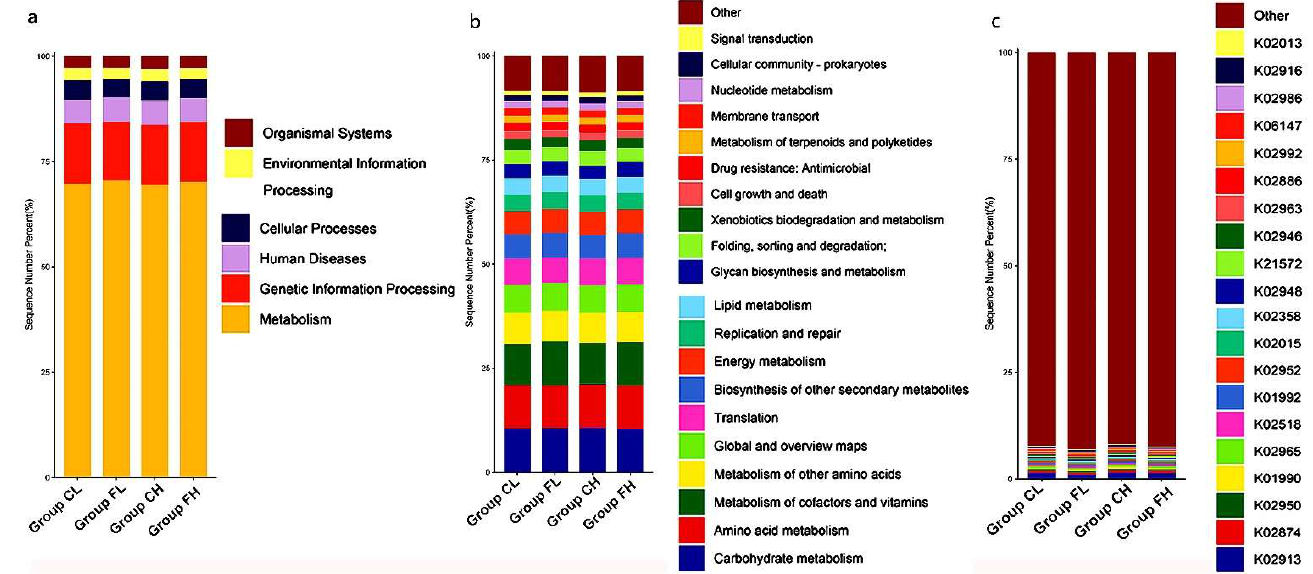
Figure 5. Relative abundance of the 20 most predominant annotated of functional KEGG between groups at ( a ) Level 1 pathway, ( b ) Level 2 pathway, and ( c ) ortholog.